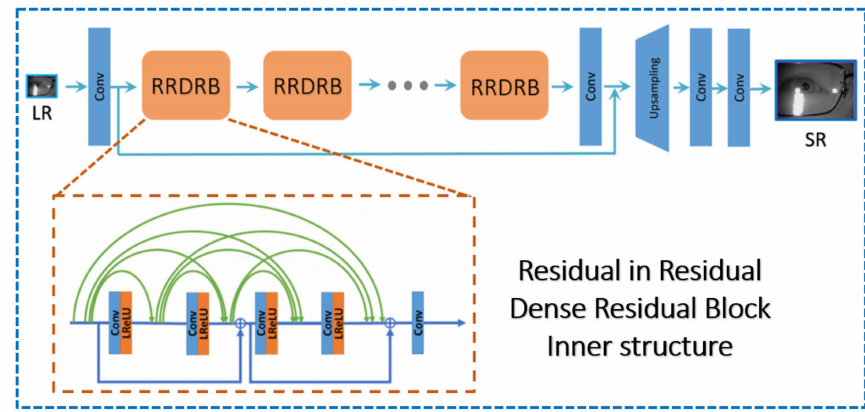
Figure 6. The network structure of the generator in nESRGAN+.